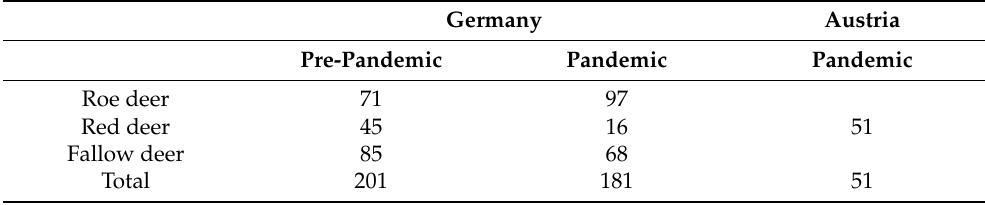
Table 1. Number and origin of samples from each deer species analyzed for anti- SARS-CoV-2 antibodies.